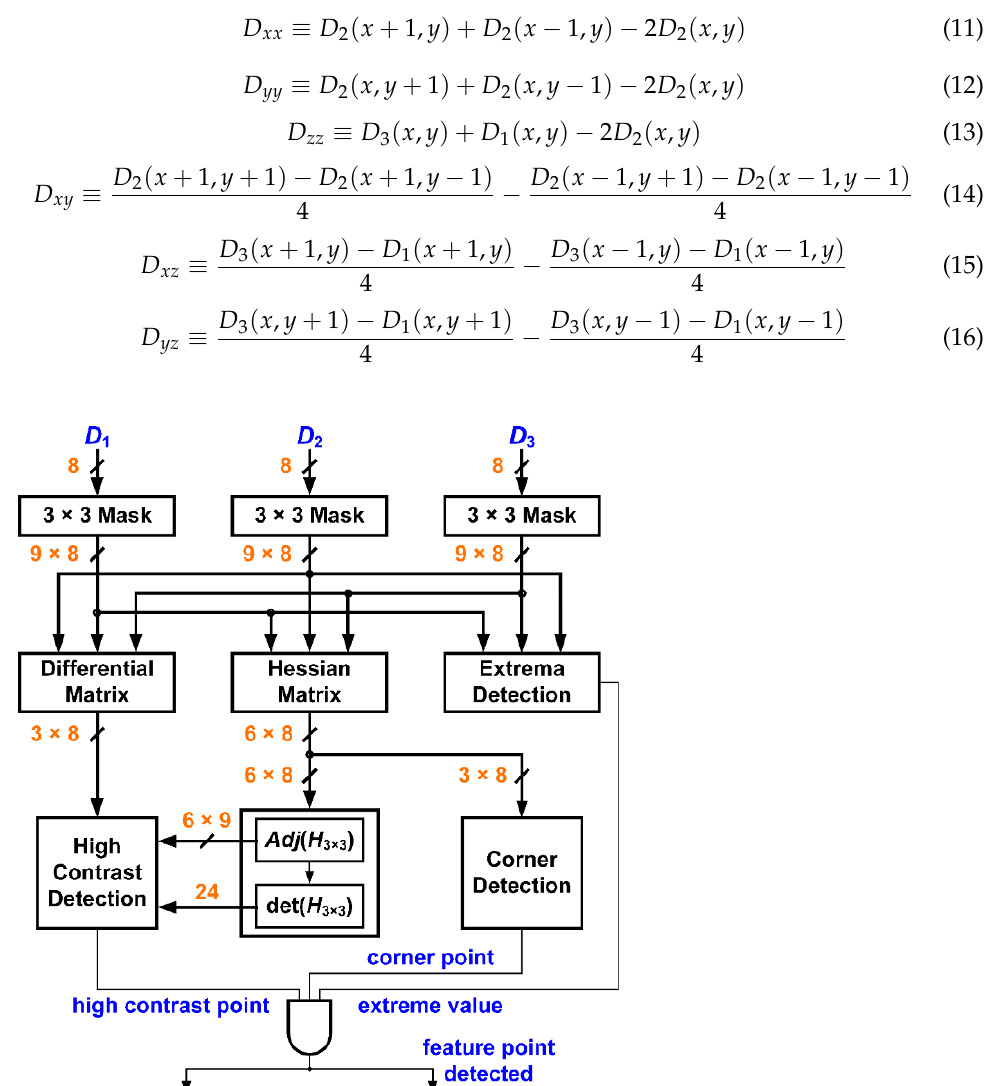
Figure 10. The detection range includes 27 pixels in three DoG images under a 3 × 3 mask, where the orange pixel is regarded as the detection point.